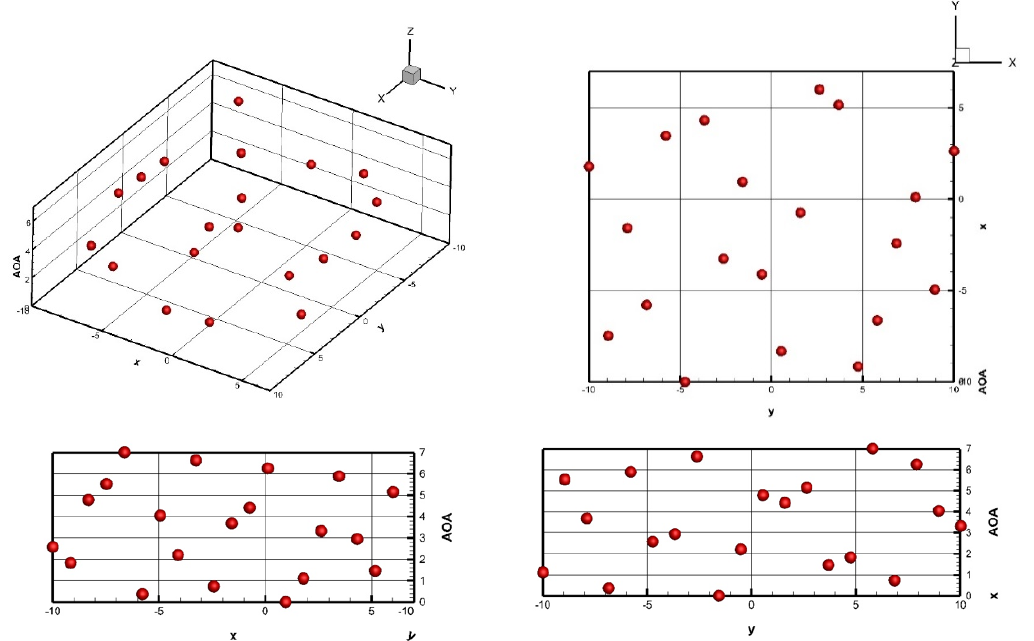
Figure 13. Distribution of sample points.